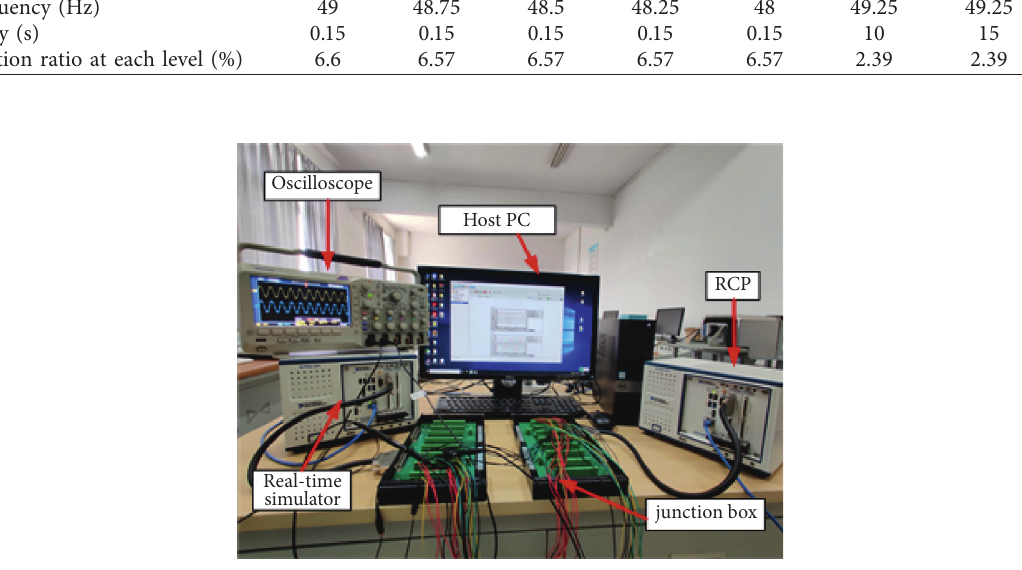
Figure 4: RCP and HIP simulation B1: 5% of the distributed photovoltaic generation ca- pacity does not have frequency endurance ability.